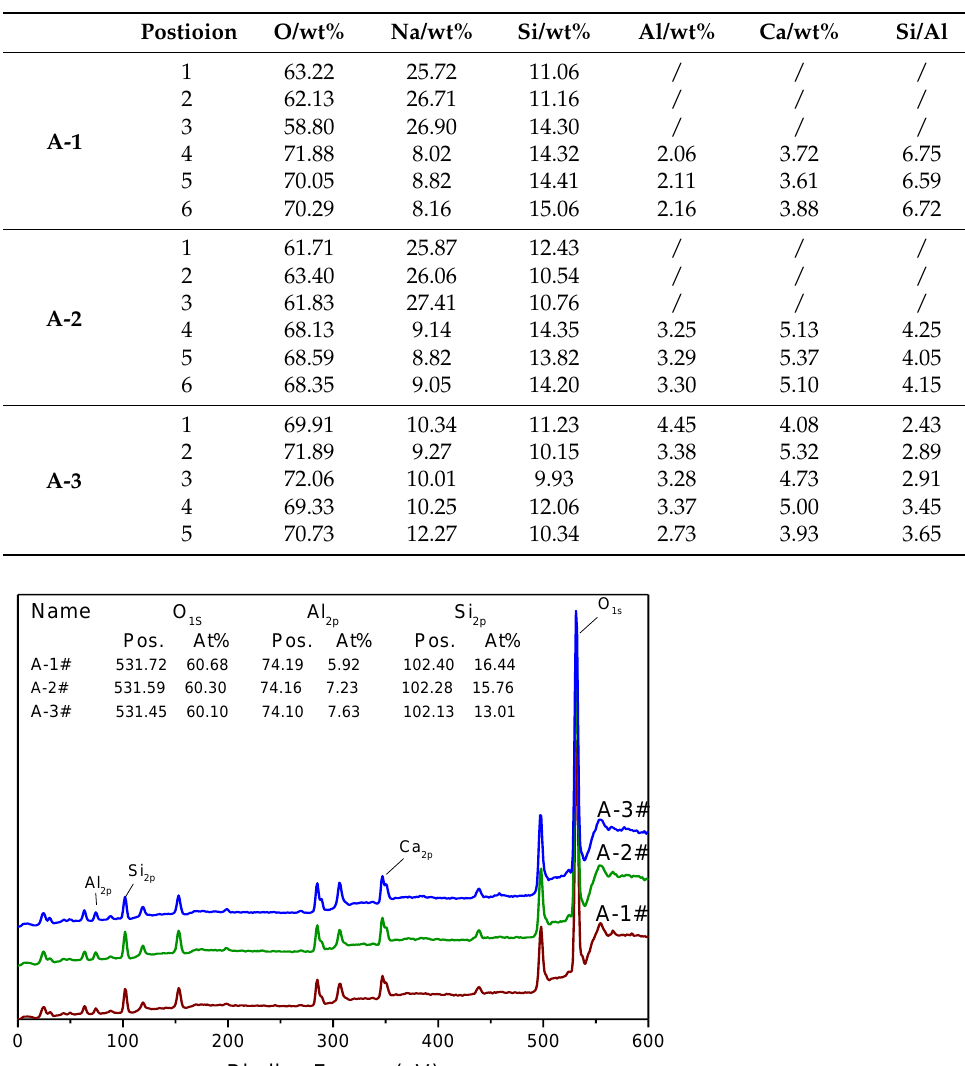
Table 4. Chemical compositions determined by EDS of crystals in Figure 8.